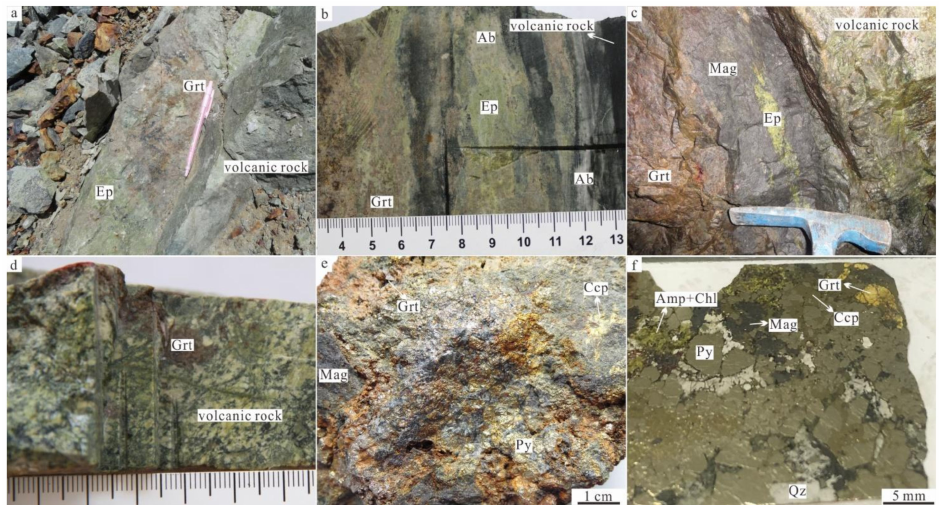
Figure 5. Photographs of garnet varieties from the Laoshankou deposit. ( a ) brown garnet in the volcanic wall rocks; ( b ) brown garnet replaced by subsequent epidote and albite; ( c ) dark red garnet adjacent to the orebody; ( d ) dark red garnet cross-cuts the diorite porphyrite near the orebody; ( e ) yellow-green garnet coexists with sulfides; ( f ) yellow-green garnet coexists with sulfides, quartz, amphibole and chlorite. Abbreviations: Ab, albite; Amp, amphibole; Ccp, chalcopyrite; Chl, chlorite; Ep, epidote; Grt, garnet; Mag, magnetite; Py, pyrite; Qz,